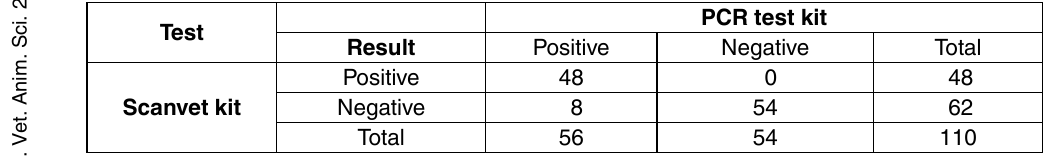
table 4. Comparison of Scanvet kit and PCR test strips